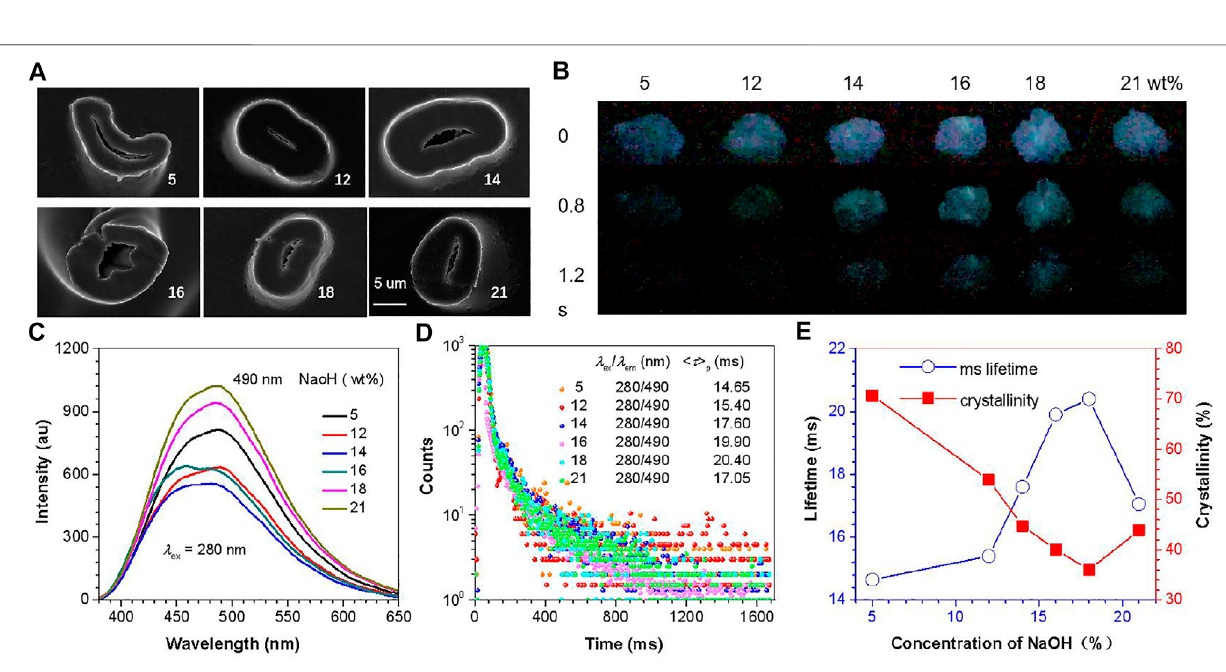
Frontiers in Chemistry |